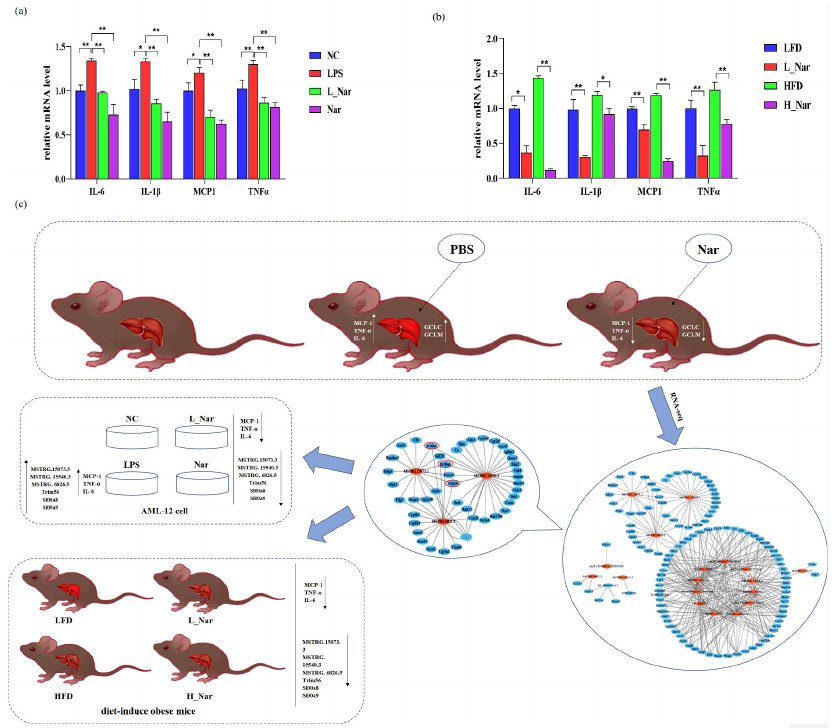
Figure 7. Effects of naringenin on AML ‐ 12 and diet ‐ induced inflammation in obese mice: ( a ) mRNA expression of IL ‐ 6, IL ‐ 1 β , MCP1, and TNF α in liver samples of the NC group, LPS group, L_Nar group, and Nar group, respectively; ( b ) real ‐ time PCR detection of inflammatory factors mRNA expression. Data are expressed as mean ± SEM ( n = 3). * p < 0.05, ** p < 0.01 . ( c ) Schematic diagram of naringenin experiment . IL ‐ 1 β : interleukin ‐ 1 β .